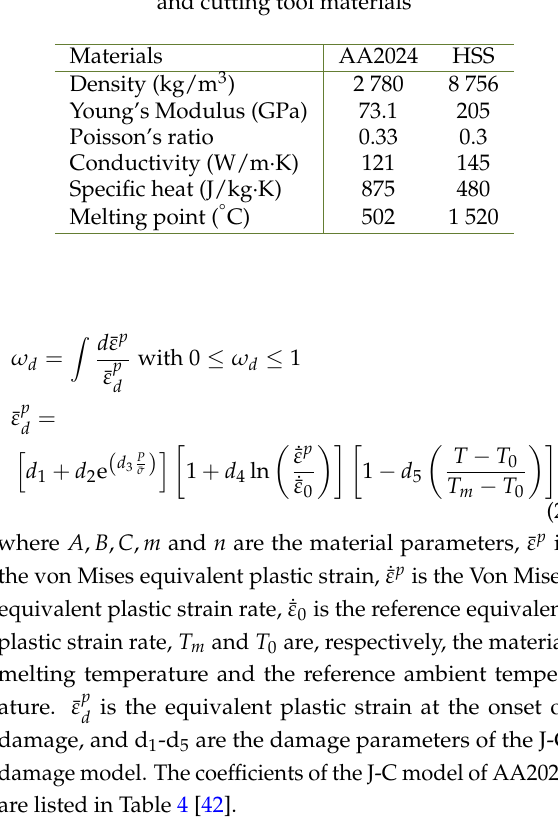
Table 2. Influencing factors and levels of drilling